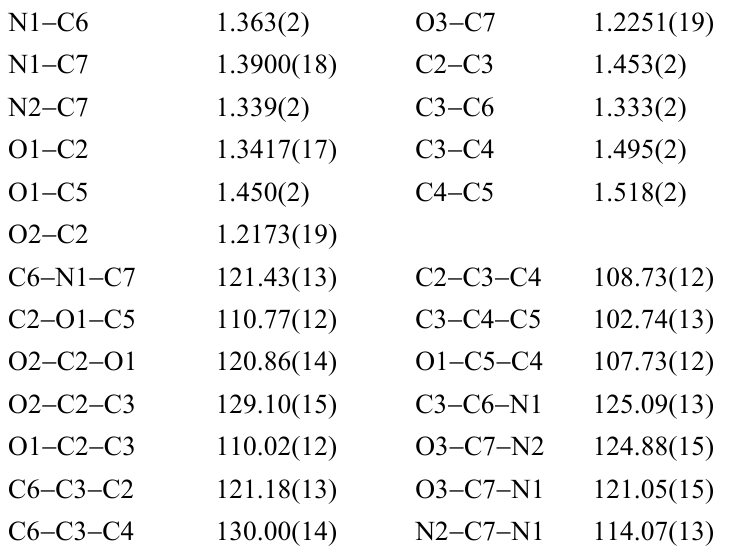
Table 1. Bond distances (Å) and bond angles ( o ) for 2 .